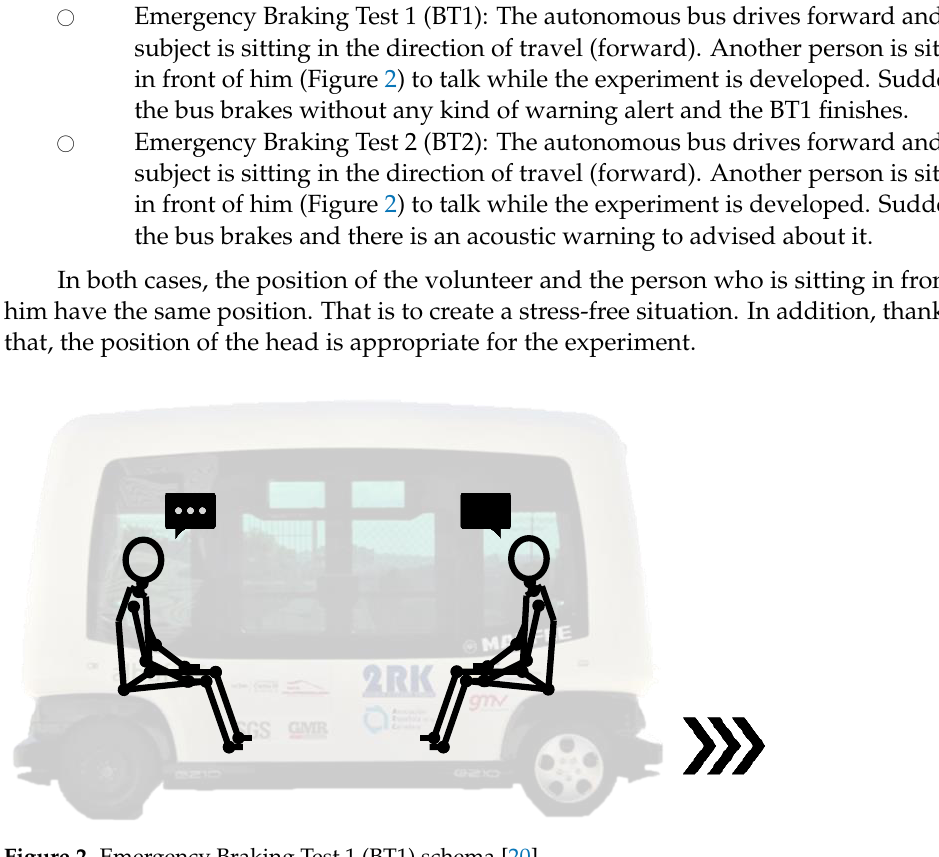
Figure 2. Emergency Braking Test 1 (BT1) schema [20].